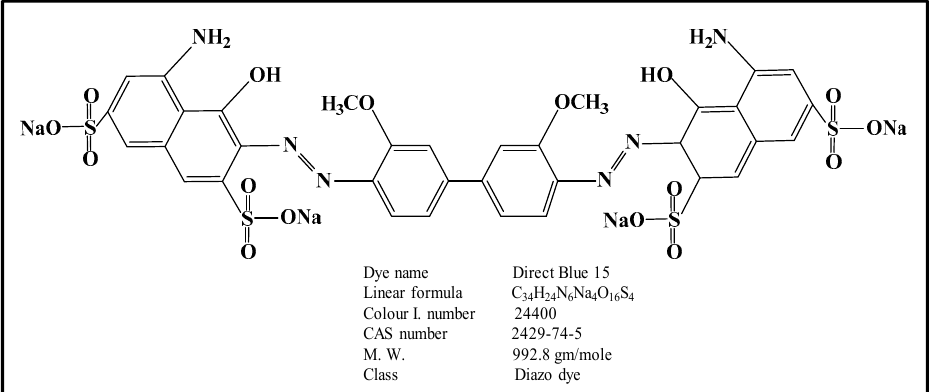
Figure 13. Chemical structure of Direct Blue 15 (DB15).